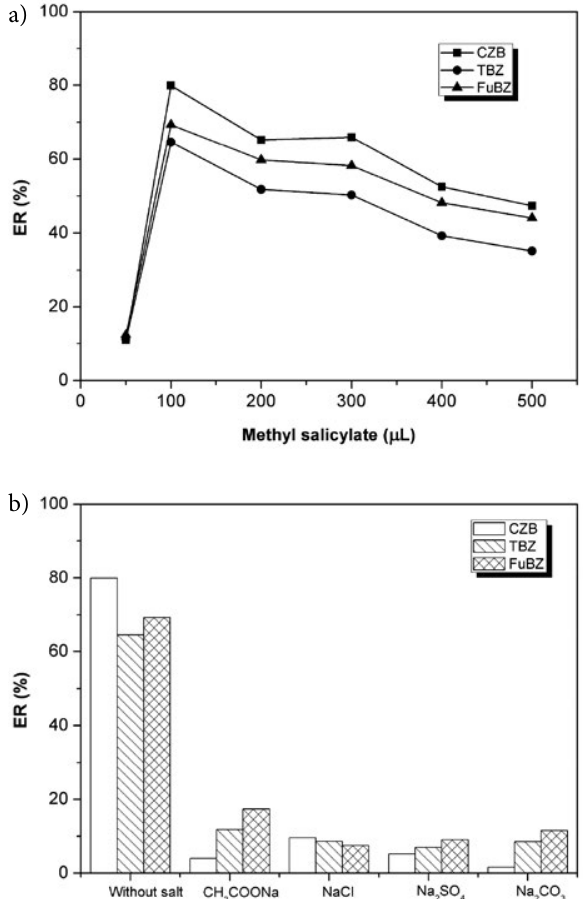
Figure 2: Effects of (a) volume of methyl salicylate and (b) salt addi- tion on the extraction recovery of the target analytes (250 µg L –1 each).